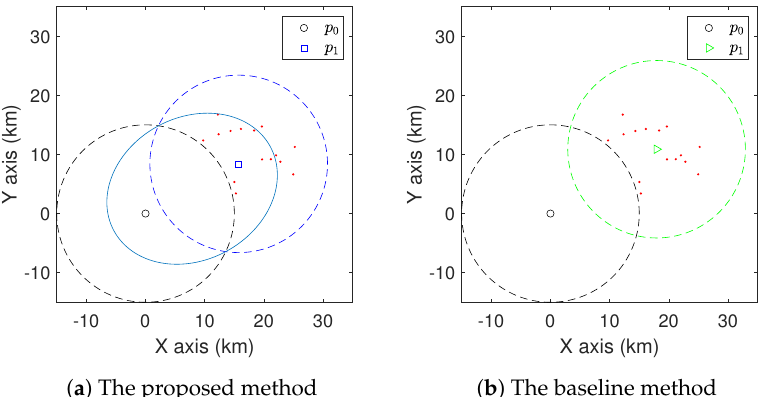
Figure 6. Comparison of the proposed method and baseline method in the second simple case with one charging station. The sites are represented by red dots.